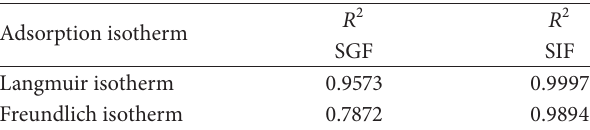
Table 3: Comparison of coefficient of determination, 𝑅 2 .